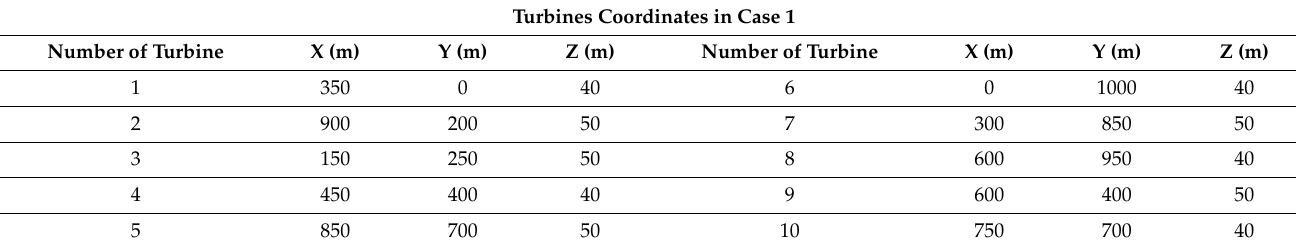
Table 6. Turbine coordinates in Case